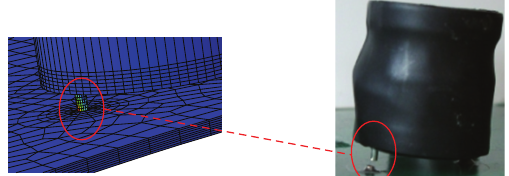
Figure 14: Component L2 failure due to in-plane and out-of-plane excitations at 3.14G rms